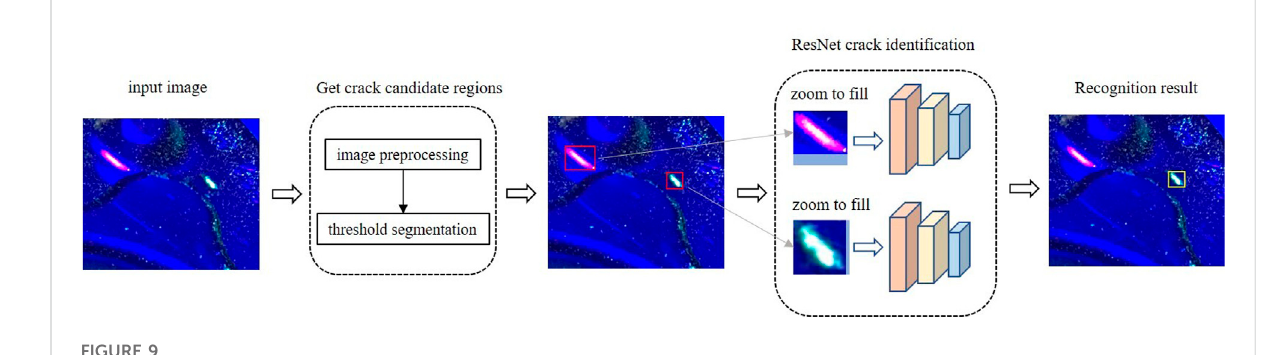
FIGURE 9 Fluorescence penetrant inspection crack identi fi cation